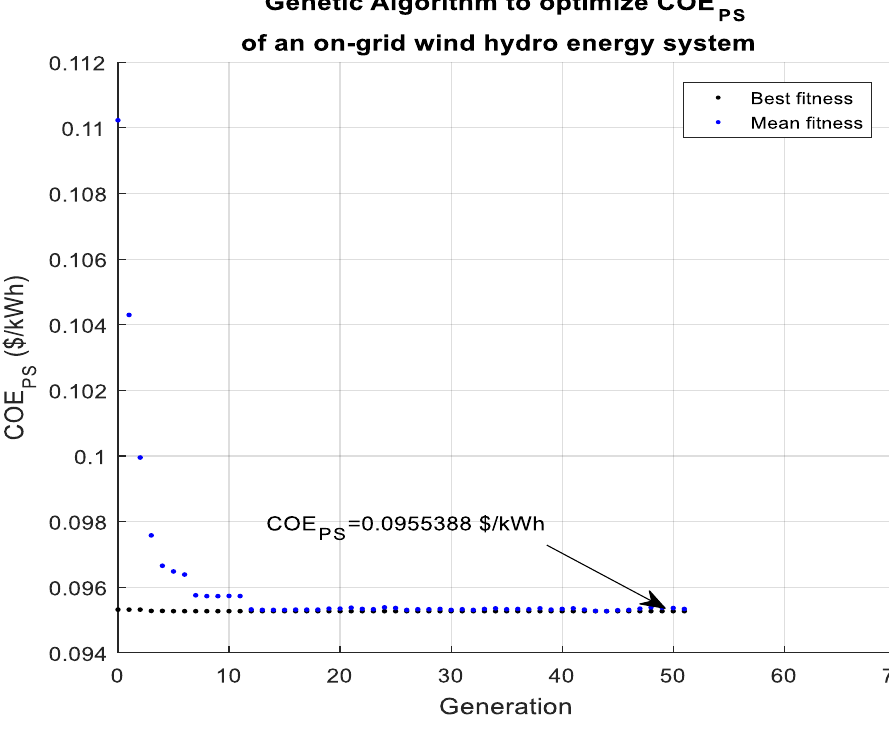
Figure 7. Corresponding decision variables of the optimal configuration. The discounted payback period (DPP) is frequently used in renewable energy studies to find the length of time needed to retrieve the initial investment [33–35]. This was done in this paper by building the cumulative cash flow (CCF), as shown in Table 5. Note that the present value factor (PVF), cash flow (CF), and the corresponding discounted cost values (CF discounted ) were calculated. The CF in Table 5 included the total cost found before in Table 4 using GA, and the energy savings of the renewable energy system. These energy savings were computed by multiplying the yearly renewable generation (436.438 GWh) by the energy purchased price of electric utilities in Jordan. Afterward, the CCF values were computed by cumulatively adding the discounted cost values. Then, the time to get back the total cost value was calculated using Equation (17). Note that Table 5 shows only 15 years of the 50-year project life-time, because the aim was to obtain a positive cost value from the CCF, which was held at the 11th year. This was just before the time when the total cost was retrieved. Table 5 shows that the DPP was computed to be around 10.271 years (10 years, 3 months, and 7 days).